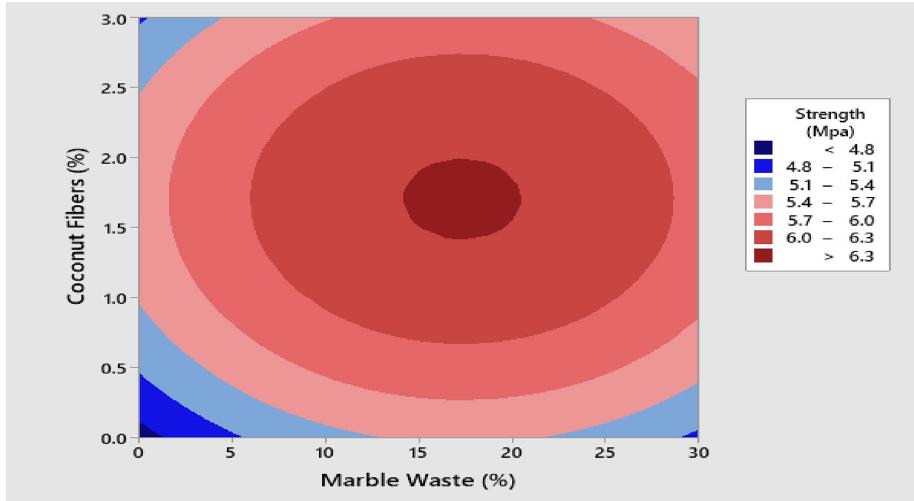
Figure 21. Contour plot for flexure strength.